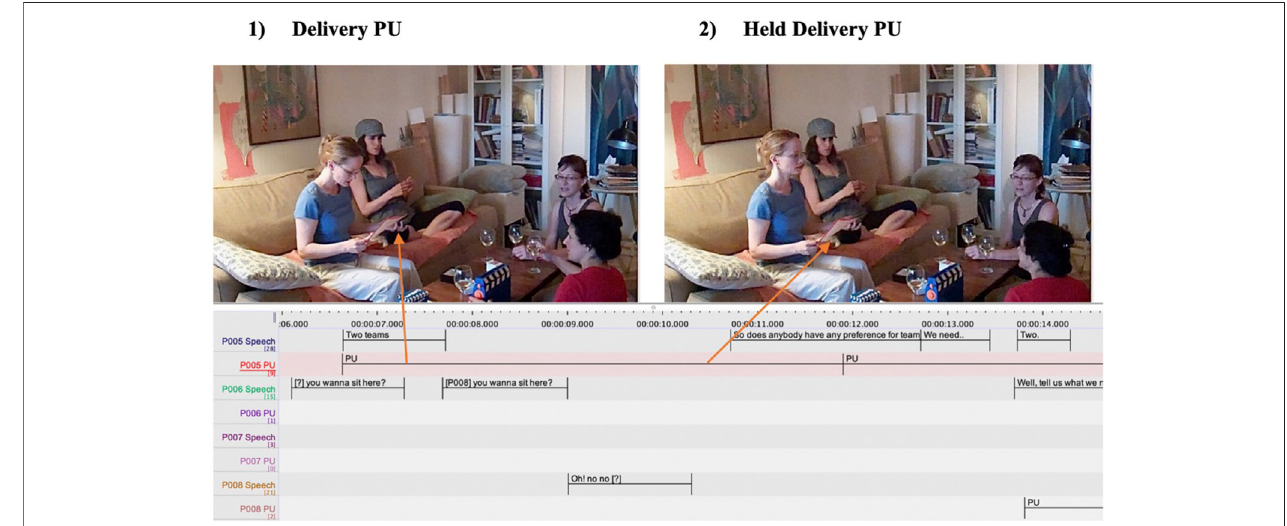
FIGURE 10 | Delivery PU in American